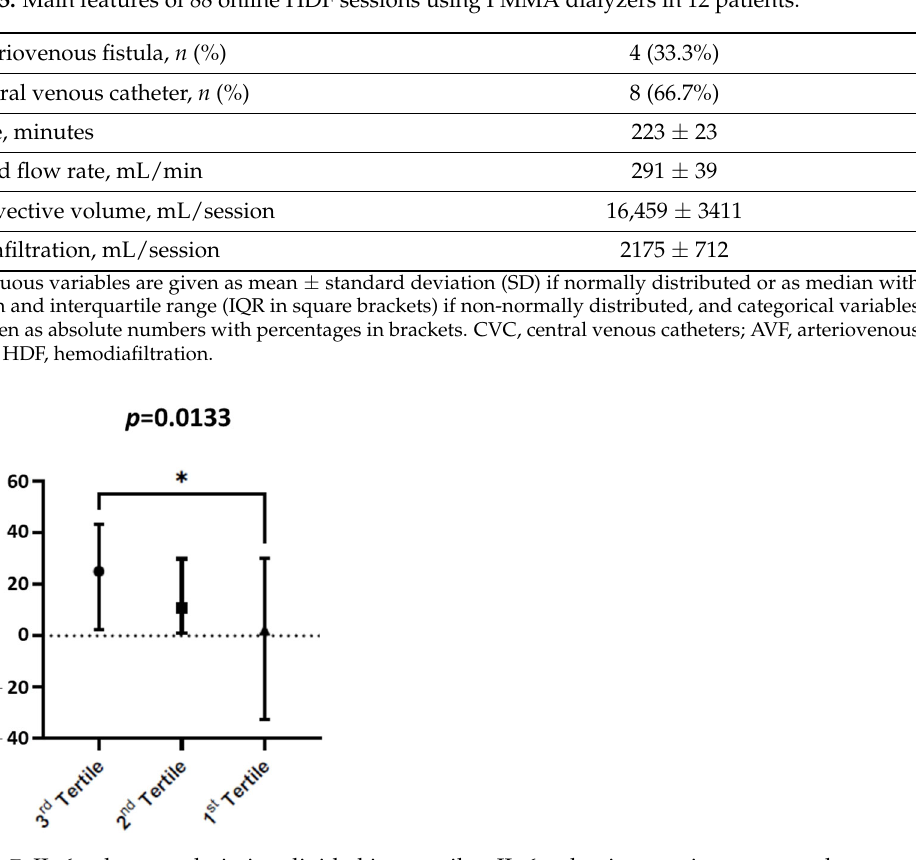
Figure 7. IL ‐ 6 values at admission divided into tertiles. IL ‐ 6 reduction rate is represented as mean and IQ range. In the first tertile, the median IL ‐ 6 reduction rate was 2.26% (IQ range: 62.64) during 29 HDF sessions; in the second tertile, IL ‐ 6 reduction rate was 10.71% (IQ range: 28.81) during